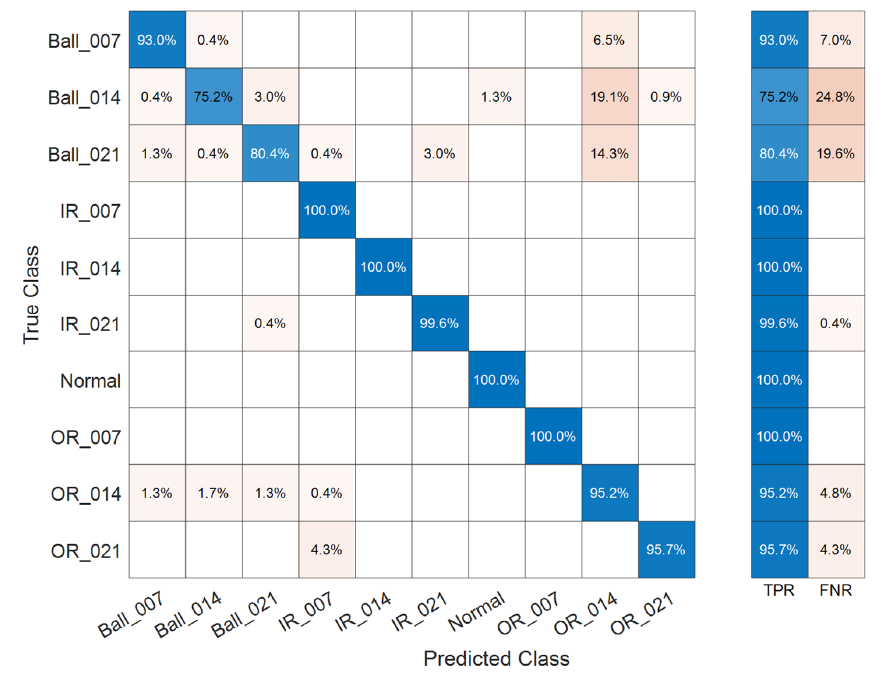
Figure 7. Confusion matrix of motor bearing failure prediction in fine Gaussian SVM, with a total accuracy of 89.6%.